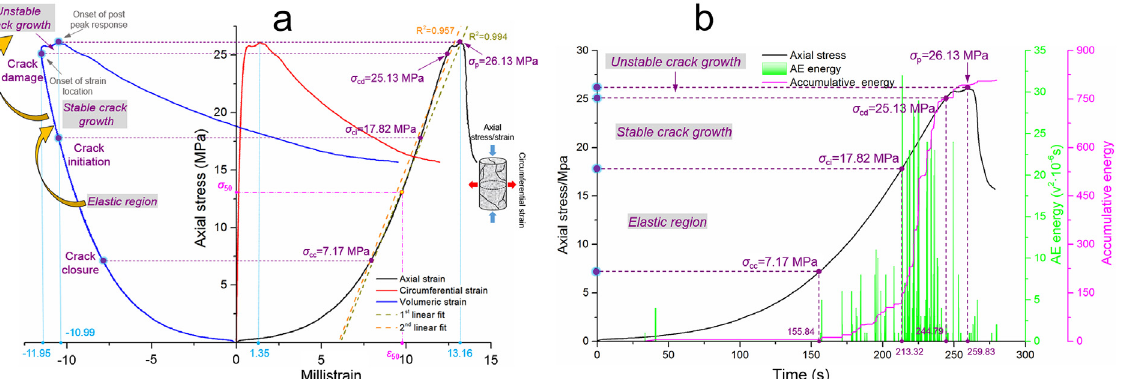
Fig 5. Test results for the restored sandstone No. 1. (a) Relationship between the axial/circumferential/volumetric strain and axial stress under uniaxial compression. (b) Relationship between the time and axial stress/AE energy/accumulative energy under uniaxial